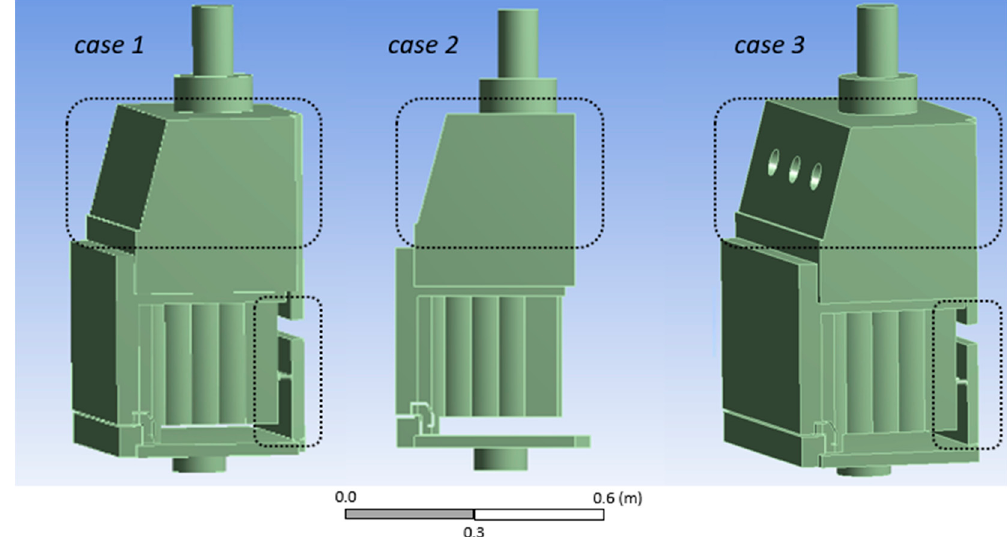
Figure 5. Three designs for a modified fireplace insert construction (Cases 1, 2, and 3) with marked structural elements that have been modified.